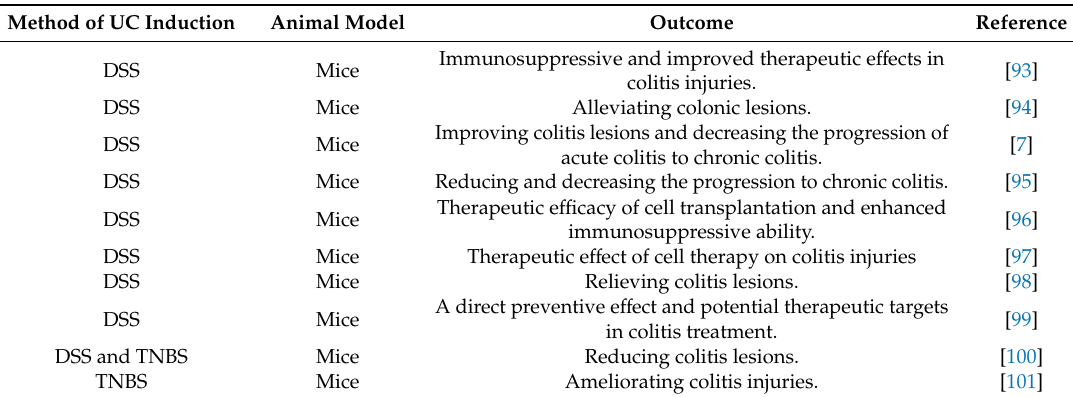
Table 6. In vivo studies in the treatment of UC using UCSCs.